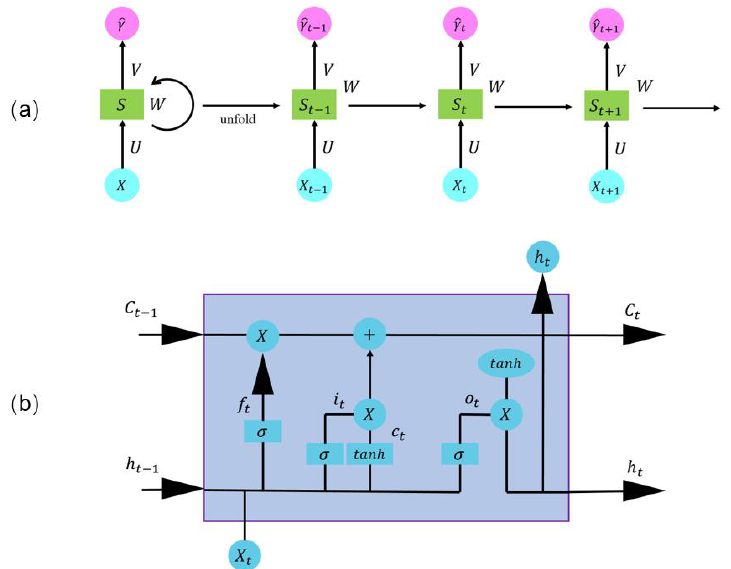
Figure 7. Illustration of RNN architecture ( a ) and the LSTM cell with input (it), forget (ft), and output gates (ot) ( b ). The forget gate (ft) uses the sigmoid activation function to selectively forget the irrelevant information (with less weight), the input gate (it) decides what to memorize using the sigmoid and tanh functions, and the output gate (ot) determines the exact output from the current cell.